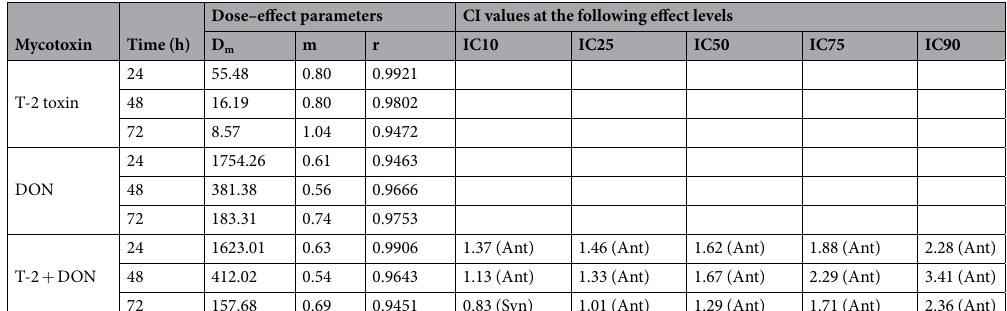
Table 4. Dose–effect relationship parameters and mean combination index (CI) values of T-2 toxin or DON alone or in combination on HK-2 cells. The parameters m, D m , and r are the slope, antilog of the x-intercept, and the linear correlation coefficient of the median-effect plot, which signifies the shape of the dose-effect curve, the potency (IC50), and the conformity of the data to the mass-action law, respectively. IC10, IC25, IC50, IC75, and IC90 are the doses required to inhibit proliferation by 10%, 25%, 50%, 75% and 90%, respectively. Ant and Syn indicate antagonistic and synergistic effect,